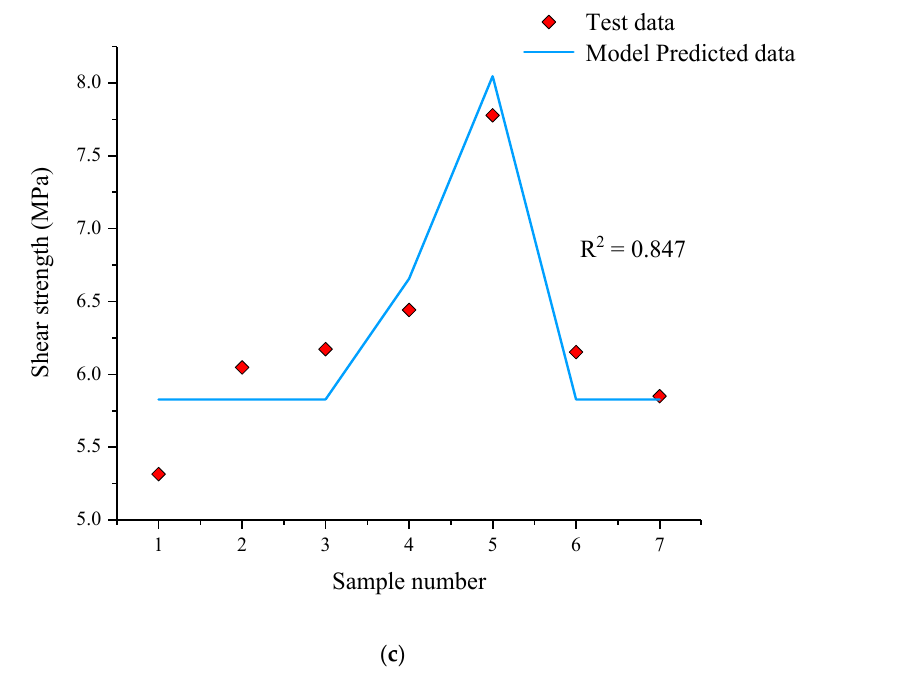
Figure 13. The comparison between the test data and predicted data being used by different models: In Figure 13, it can be realized that XGBoost had the lowest prediction accuracy with an R 2 of 0.759, and WOA-XGBoost has the highest prediction accuracy and the best agreement between the predicted data and test data with an R 2 of 0.902. PSO-XGBoost had a prediction accuracy between those of XGBoost and WOA-XGBoost with an R 2 of 0.847. WOA-XGBoost achieved a very good fit between the predicted data and the test data for shear strength. Therefore, the WOA-XGBoost model was selected as the prediction model in this study, and the weight share of each micro-parameter was calculated based on the weight calculation module of the algorithm, and the results are shown in Figure 14.